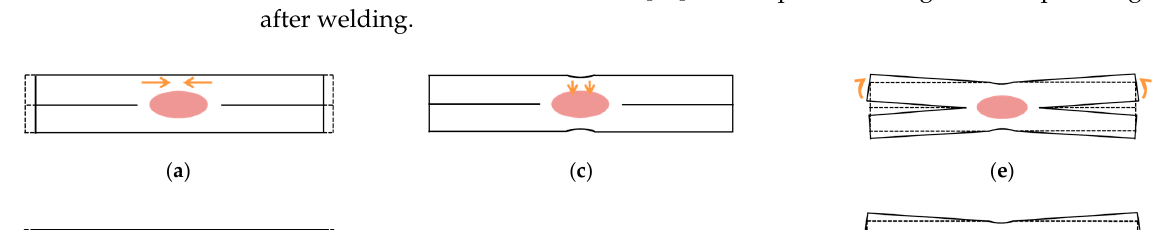
Figure 6. Nugget model.